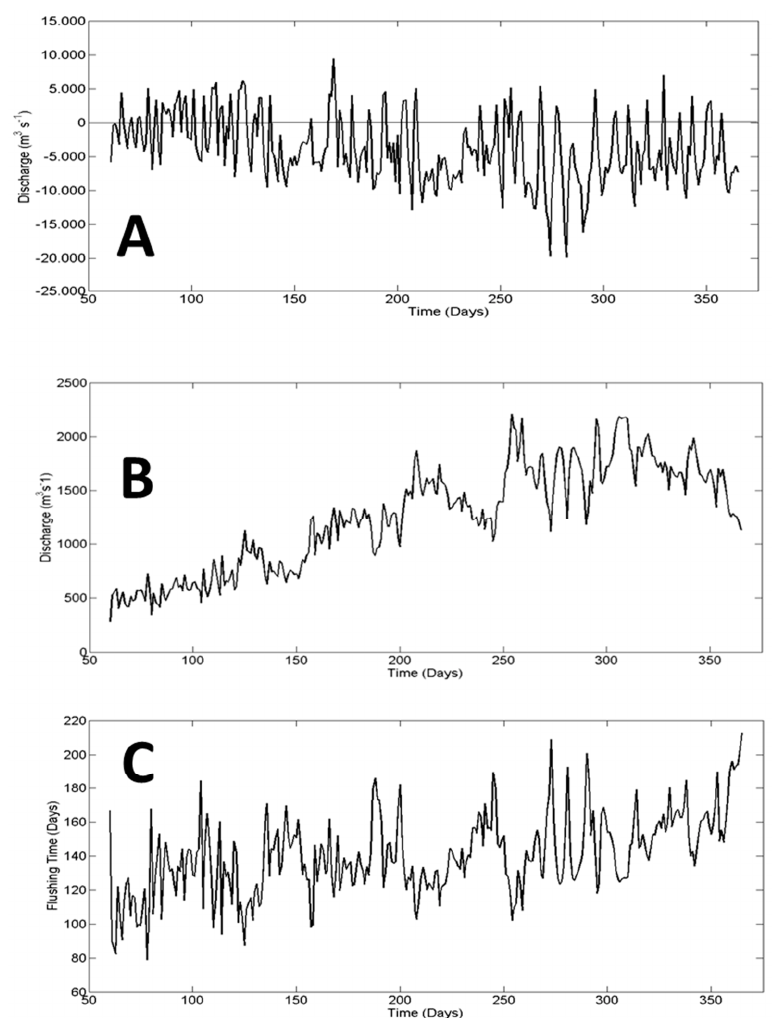
Figure 12. ( A ) Temporal variability in the Patos lagoon discharge to the coastal region. Positive values represent flood, while negative values represent ebb conditions. ( B ) Simulated temporal variability of the Mirim lagoon freshwater discharge to the Patos lagoon during the simulated period (2002). ( C ) Modeled flushing times for the Mirim lagoon in 2002.